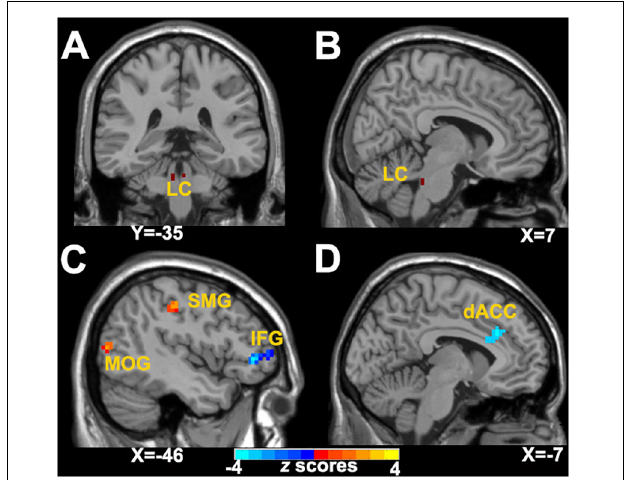
FIGURE 1 | Abnormal LC-NE functional network in patients with CID. (A , B) LC seed selected from AAL 3 atlas. (C) Altered brain regions in the left LC-NE functional network in patients with CID are found in the left IFG, IPL, and MOG. (D) Altered brain regions in the right LC-NE functional network in patients with CID are found in the left dACC. LC-NE, locus coeruleus-norepinephrine; CID, chronic insomnia disorder; IFG, inferior frontal gyrus; MOG, middle occipital gyrus; SMG, supramarginal gyrus; dACC, dorsal anterior cingulate cortex; AAL, automated anatomical atlas.